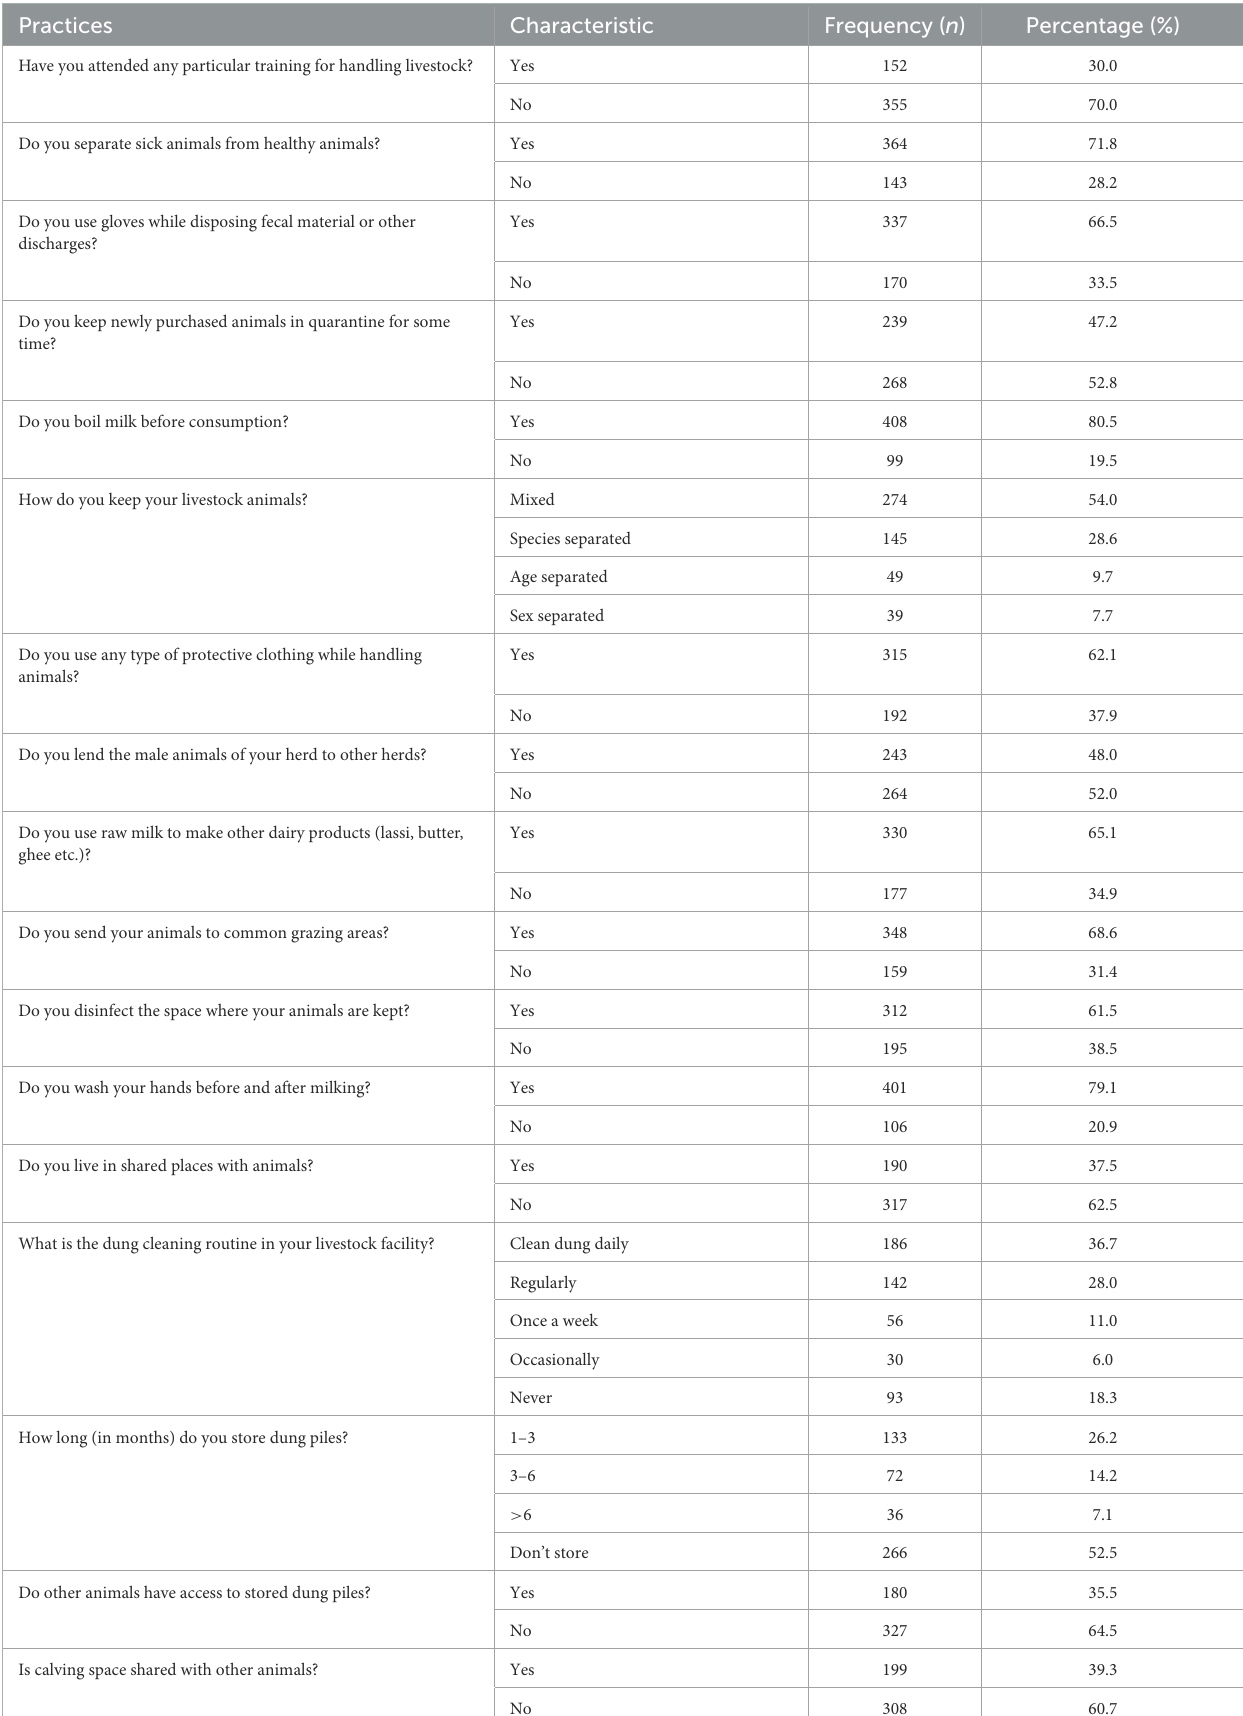
TABLE 5 Participants’ practices for preventing the spread of schistosomiasis and fascioliasis. Practices